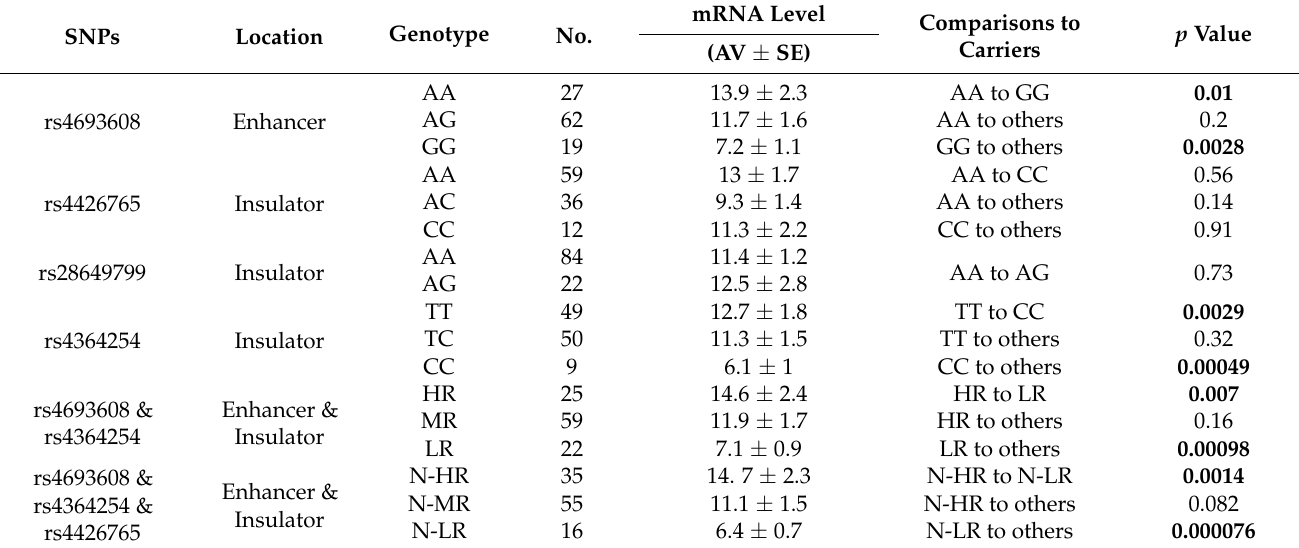
Table 6. Association between enhancer and insulator HPSE gene SNPs and relative heparanase mRNA expression level among healthy